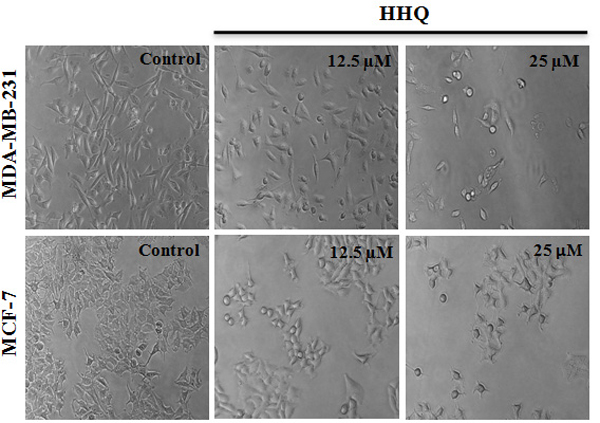
Phase contrast images of human breast cancer cells (MDA-MB-231 and MCF-7). The breast cancer cells were exposed to 12.5 µM and 25 µM concentration of HHQ for 48 h at 37 °C. HHQ treated groups did not retain their normal morphology. HHQ induced cell rounding and detachment in breast cancer cells.